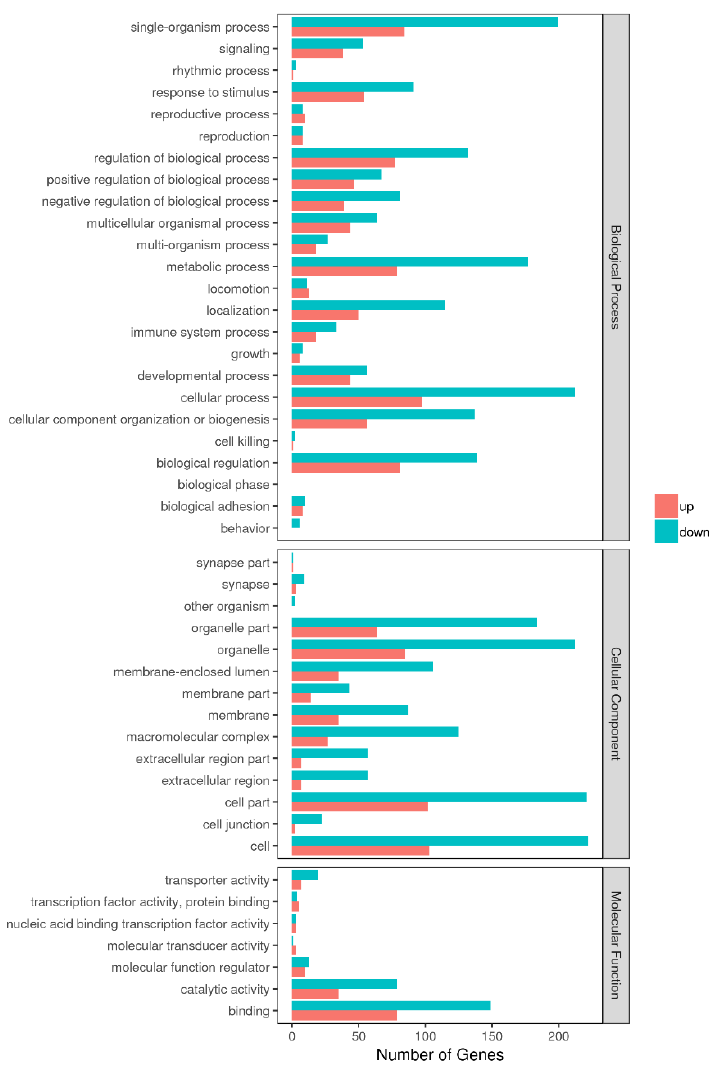
Figure 3. GO enrichment analysis of DEGs in Tas-exo vs NC; GO terms (X axis). Enrichment ratio of genes shown as GO terms for biological process (BP), cellular component (CC), and molecular function (MF).